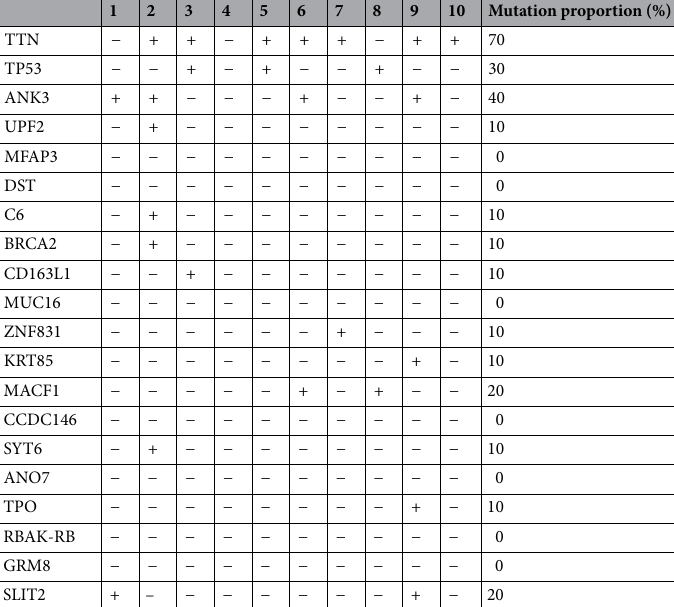
Table 3. Comparison of the TOP20 genes of hypopharyngeal carcinoma in the TCGA database and the samples in this research. + mutated in the sample, − not mutated in the